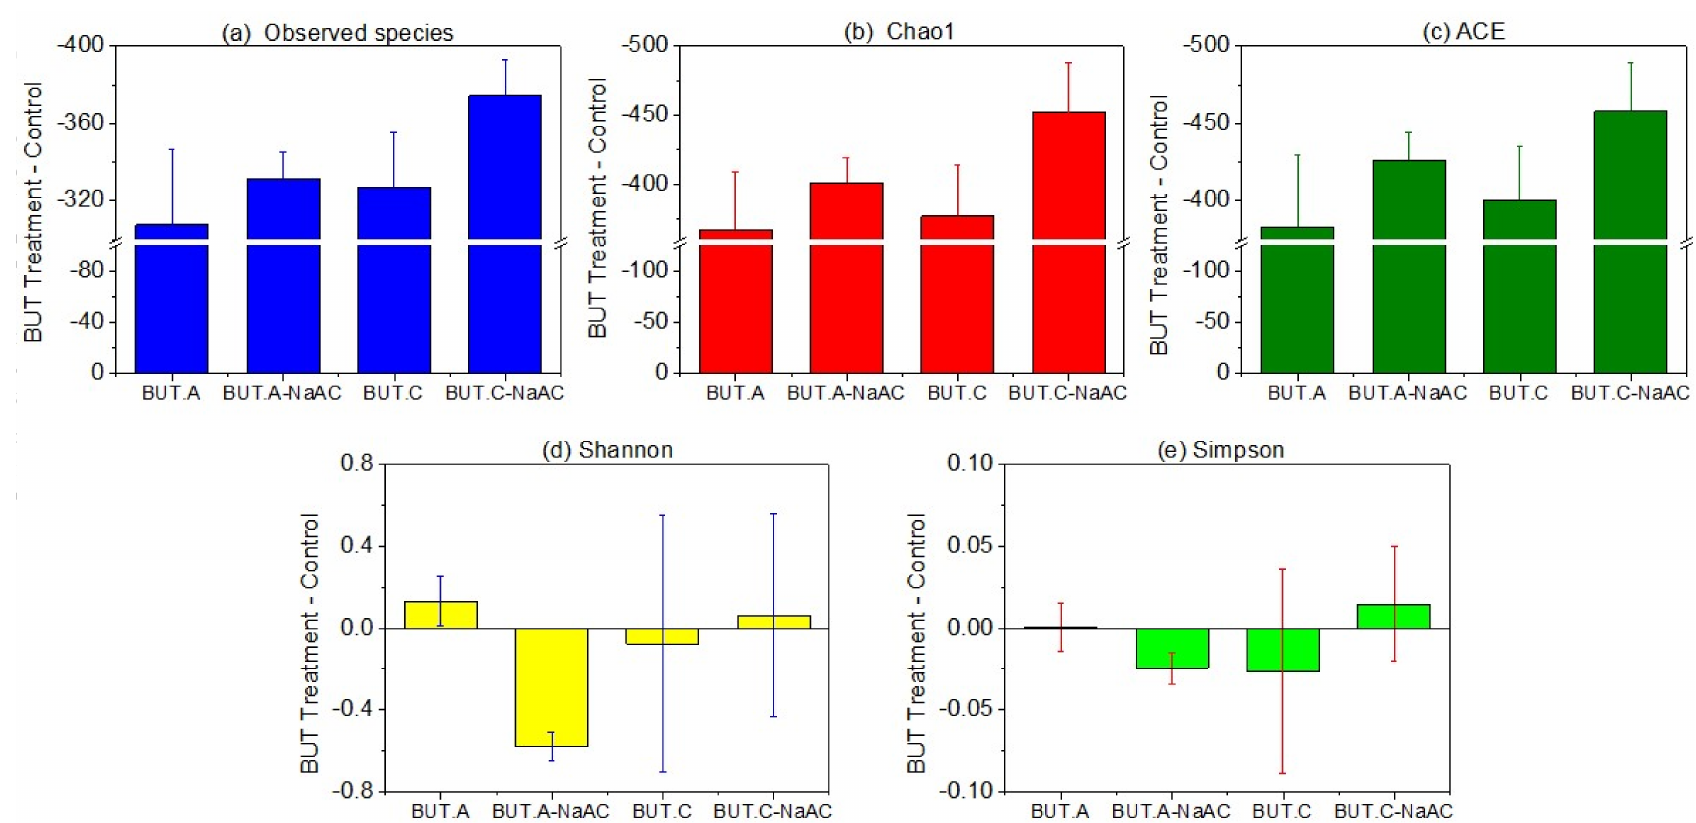
Figure 2. The Alpha diversity index changes on the anode (A) and cathode (C) of MFCs; ( a ): observed species, ( b ): Chao 1 index, ( c ): ACE index, ( d ): Shannon index and ( e ): Simpson index; Y -axis = BUT treatment − control. The values of controls are shown in Table S1 (Supplementary Materials). The data are presented as means ± standard error (SE) from duplicate